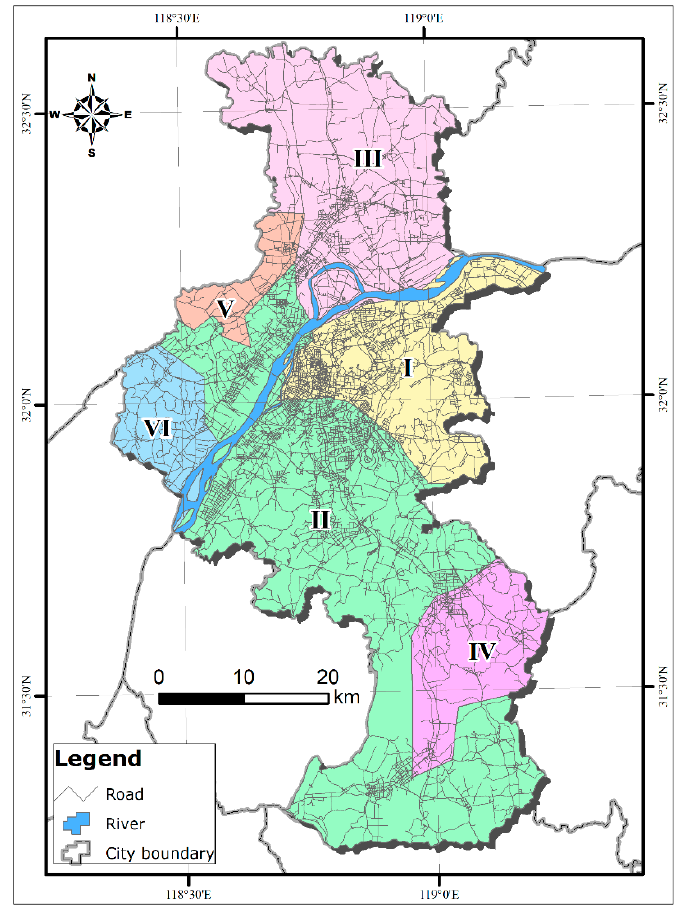
Figure 4. Regionalization result of the sink. (Note: The whole of Nanjing is divided into six regions, and each region is coded in Roman numerals.).